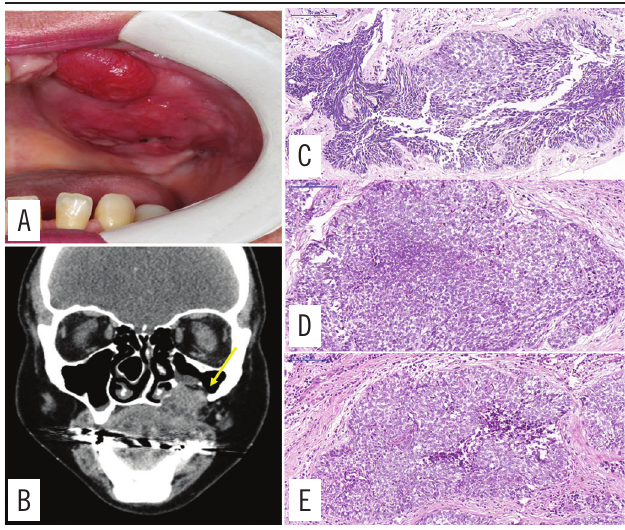
figura 3 − A) visão clínica pré-operatória da última recorrência da lesão; B) TC que mostra imagem hipodensa com ruptura extensiva da cortical óssea e invasão do seio maxilar (seta amarela); C) fragmentos de neoplasma maligno de origem epitelial odontogênica, mostrando atipia celular e pleomorfismo, hipercromatismo nuclear, focos de degeneração cística e necrose (HE, 500 µm); D) áreas focais de desmoplasia (HE, 100 µm) TC: tomografia computadorizada; HE: hematoxilina e